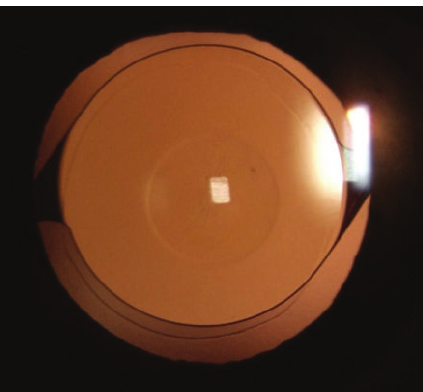
Figure 1: A slit-lamp retroillumination photograph of the Presbia Microlens and intraocular